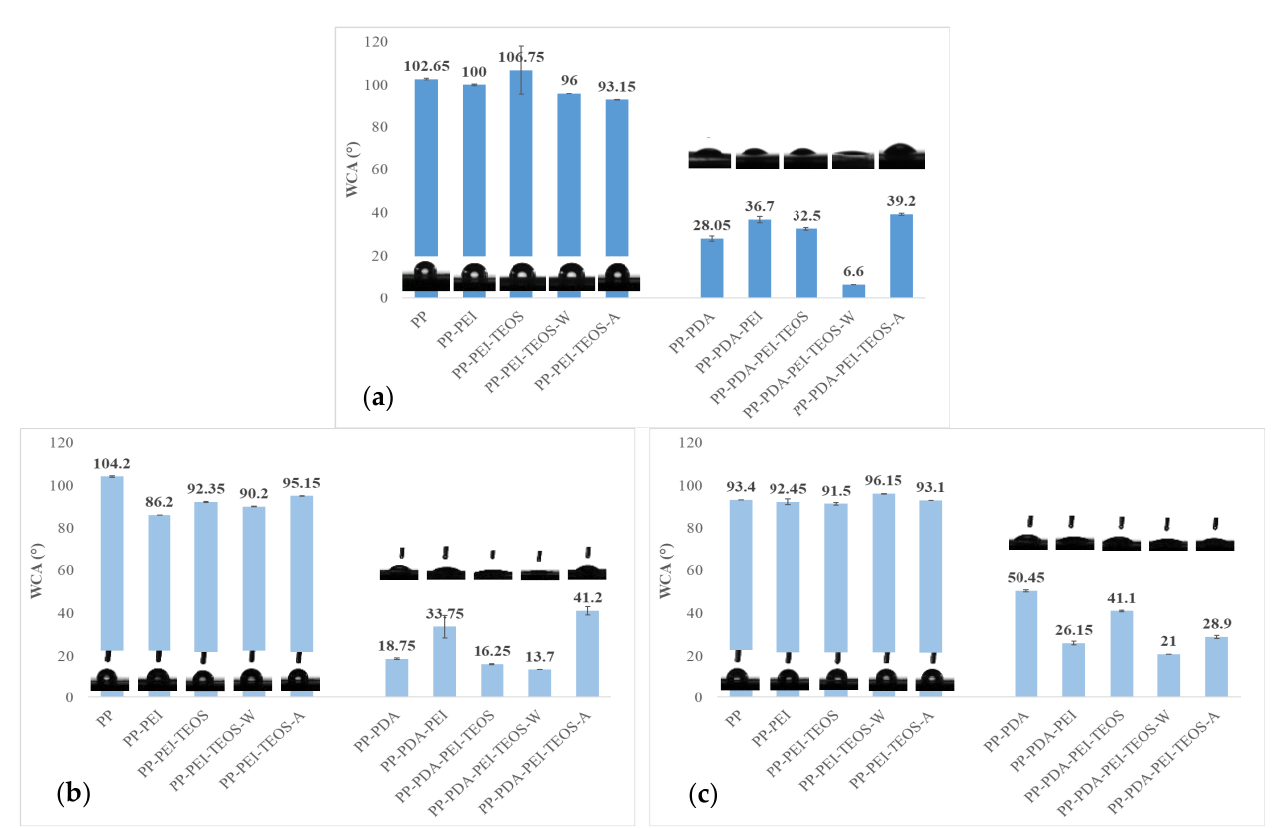
Figure 5. WCA of (un)modified PP films: ( a ) before incubation; ( b ) after 3 days of incubation in SBF; and ( c ) after 7 days of incubation in SBF.